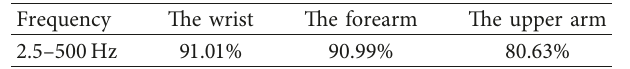
Table 5: The goodness of fit at different sets between the 6MF-30 Measured and the Modeled.